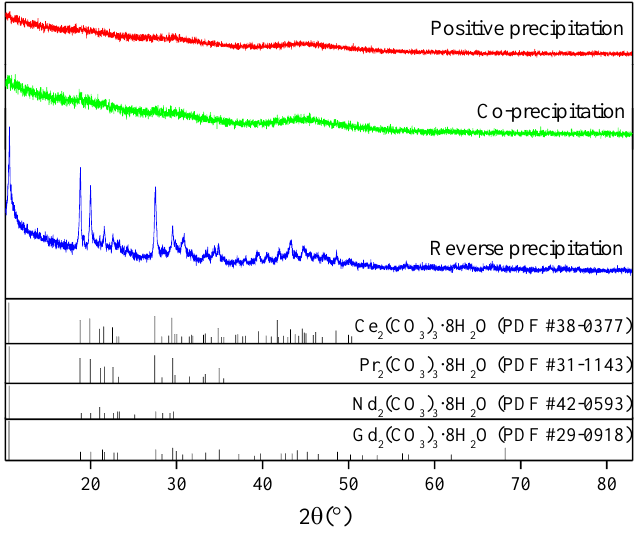
Figure 10. XRD pattern of precipitation products when using different feeding methods.